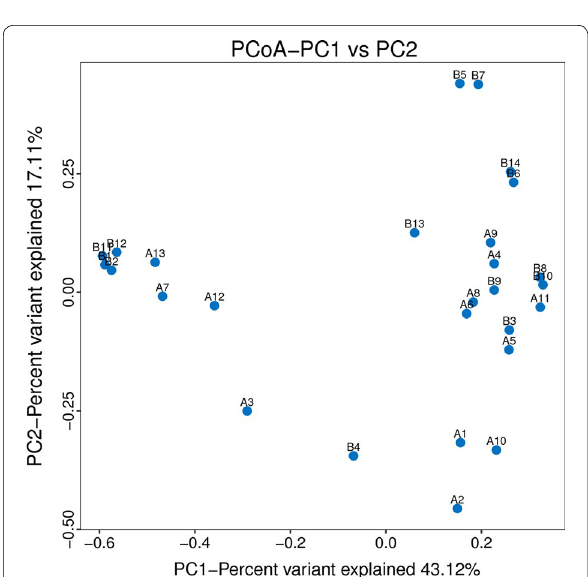
Fig. 3 PCoA plot. There were overlaps among four clusters of the 27 samples from groups A and B. Samples A7, A12, A13, B1, B2, B11, and B12 were similar, as were the communities of samples A1, A2, A3, B4, and A10, while the other samples belonged to the same